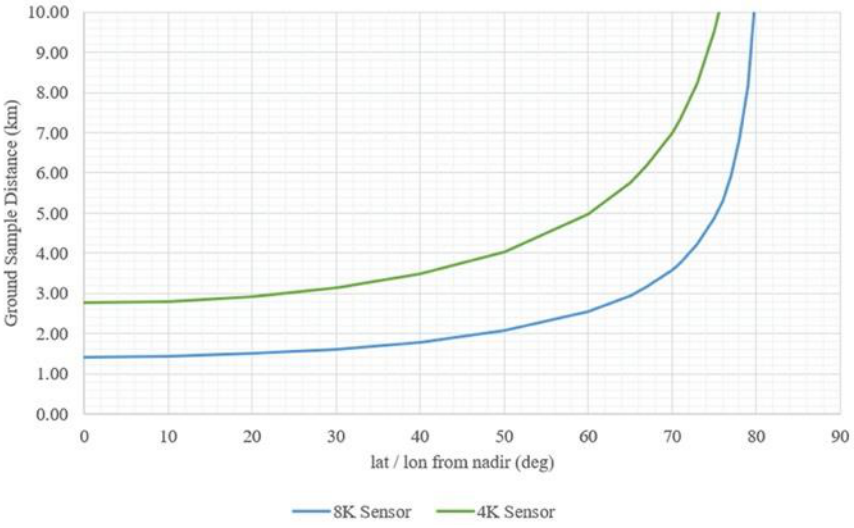
Figure 13. Ground Sample Distance as a function of angular distance from satellite nadir for 4K and 8K sensors at GEO altitude.